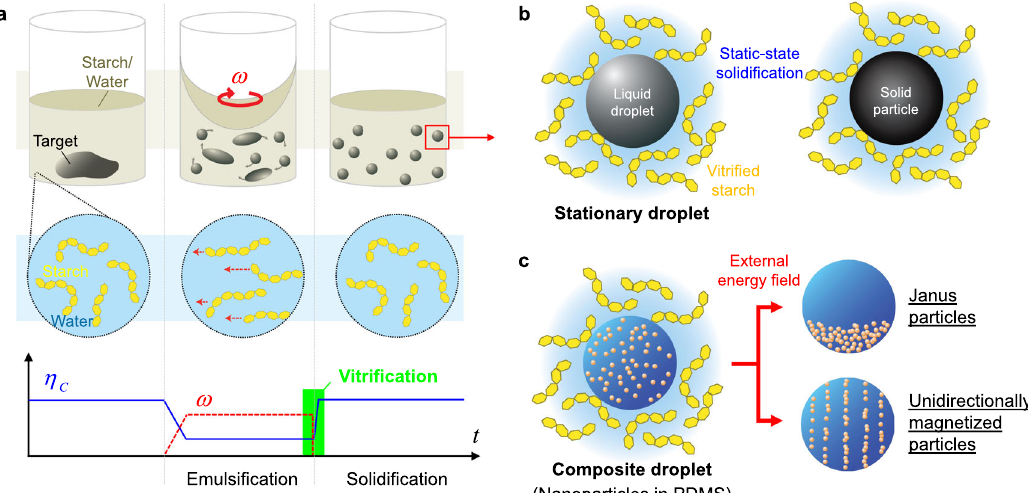
Fig. 1 Overview of the static-state particle fabrication process. a The viscosity of the starch/water medium η C decreases with the presence of a shear force (shear rate ω ) in the emulsi fi cation stage, and abruptly increases to the initial value when the shearing is stopped. This abrupt increase in η to the vitri fi cation of the medium, fi xing the distributed phase (emulsion droplets) in place. b Stationary droplets isolated in the vitri fi ed medium undergo the static-state solidi fi cation devoid of deformation forces or coalescence, enabling the droplets to preserve their shape and size during the solidi fi cation.